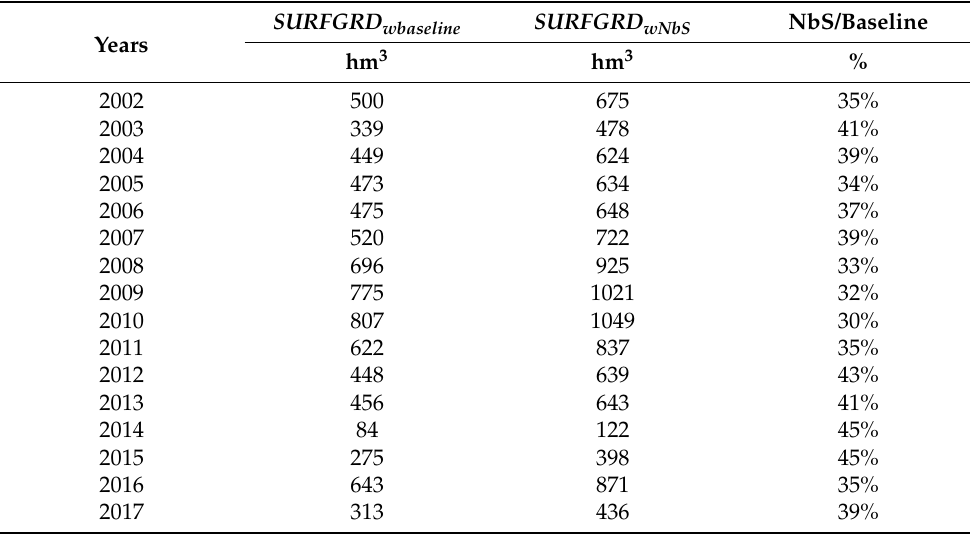
Table 2. Combined surface (SURF) flows and groundwater stream (GRDw) flows for all subwater- sheds in CWSS in the baseline and NbS scenarios, respectively.